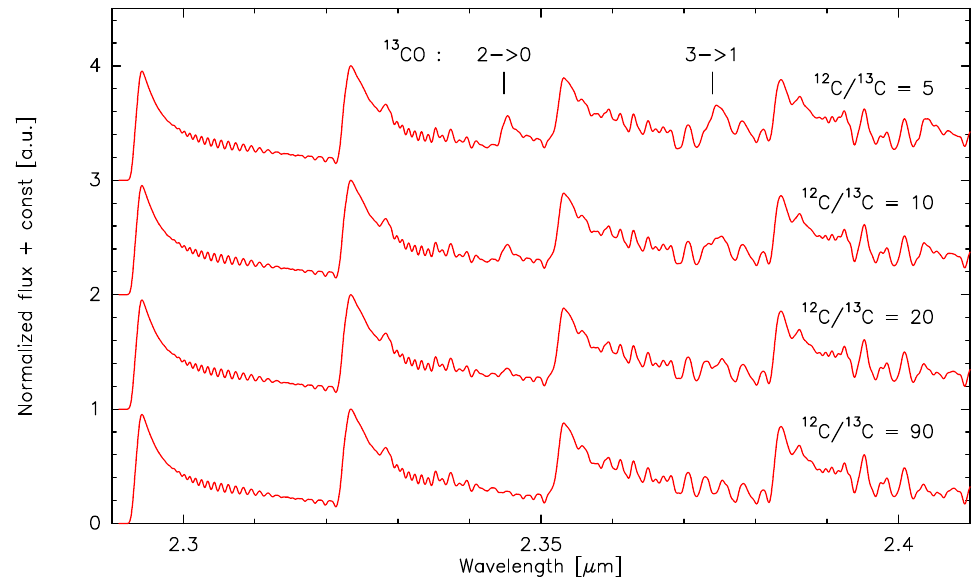
Figure 3. Synthetic spectra of the combined emission from 12 CO and 13 CO for different values of the 12 C/ 13 C ratio. The computations have been performed for the following physical parameters: a 12 CO column density of 2 × 10 21 cm − 2 , a gas temperature of 3000K, a line-of-sight rotational velocity of 66kms − 1 , and a spectral resolution of 50kms − 1